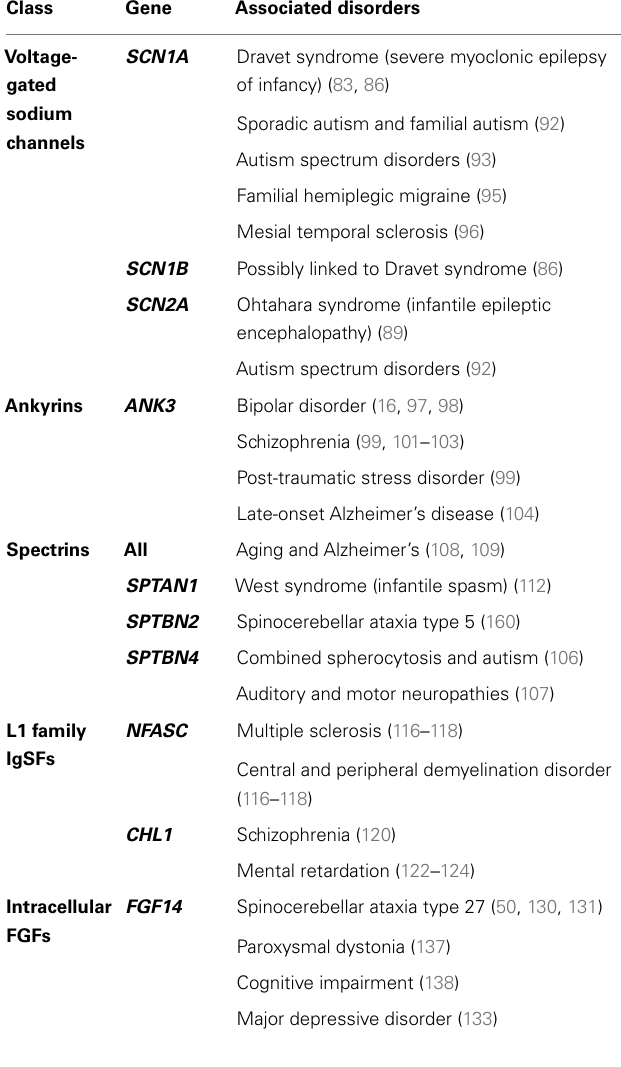
Table 1 |A selection of human disorders associated with dysregulation of keyAIS components